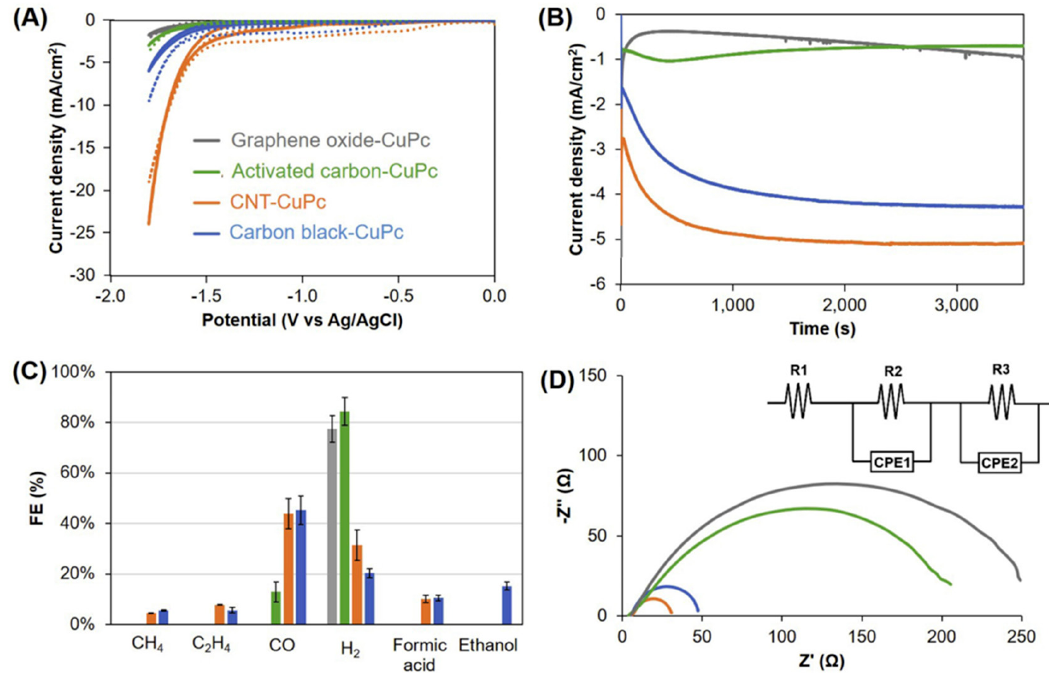
Figure 12. ( A ) CV measurements of various carbon-supported copper(II) phthalocyanines in CO 2 - saturated (marked in continuous lines) and N 2 -saturated (marked in dotted lines) 0.5 M KCl solu- tion. ( B ) Chronoamperometry measurements of the materials over 1 h under an applied potential of − 1.05 V vs. RHE. ( C ) Corresponding product analysis results from chronoamperometry runs. ( D ) EIS spectra for the materials under study are shown by their Nyquist plots, where CPE stands for constant phase element (Reprinted with permission from Ref. [159]. Copyright 2020